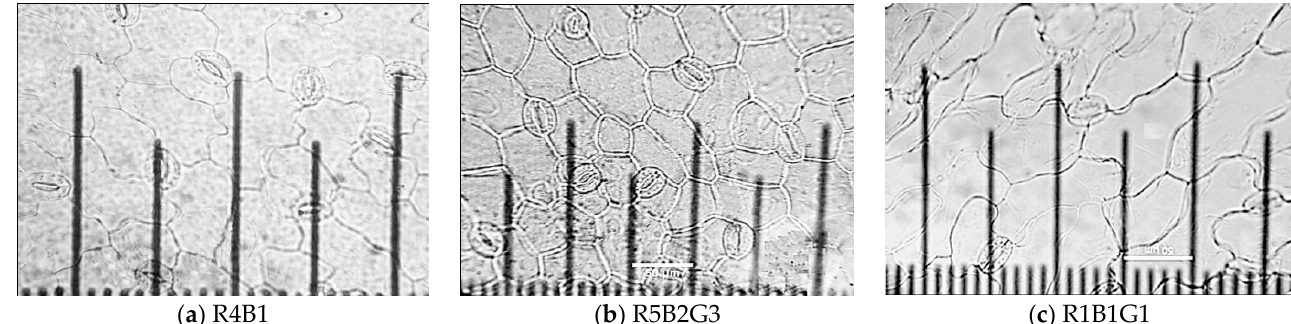
Figure 4. Characteristics of the stomatal cells in the adaxial spinach epidermis leaves for the different light qualities. The error bars show the standard errors. Data were analyzed by R software. Different letters indicate a significant difference among treatments ( p ≤ 0.05).